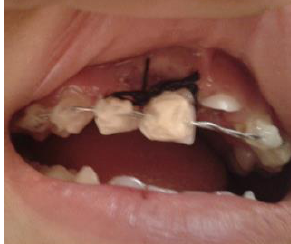
Figure 1: Suturing of soft tissue and fixation of teeth using two twisted dental needles.